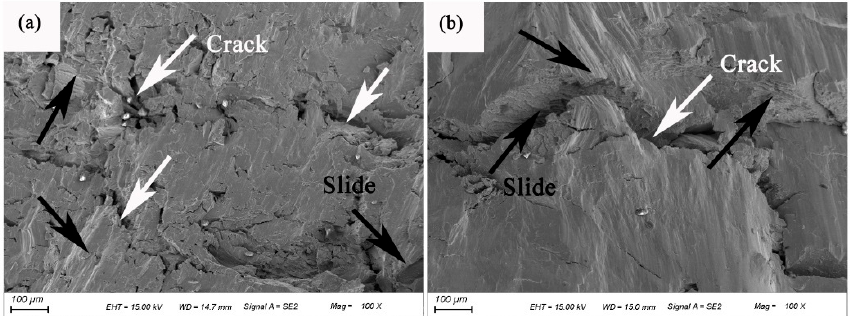
Figure 6. Scanning electron microscopy (SEM) micrographs of fracture surface for ( a ) Ti 66.7 Cu 33.3 and ( b ) Ti 61.7 Cu 33.3 Nb 5.